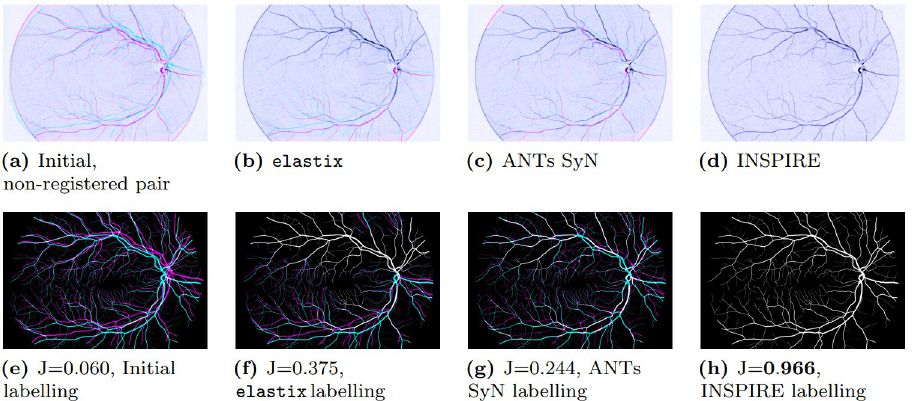
Fig 1. Example of registration of retinal images. Top row (as magenta/cyan overlays of the corresponding image pair; the better the alignment of the vessel networks, the less magenta/cyan colour visible in the image): (a) Initial deformation, and the results of registration using (b) elastix [11], (c) ANTs SyN [10], and (d) INSPIRE. Bottom row : The respective (Ground Truth) segmented vessel networks in the observed images in the top row (only used for evaluation, not for registration), with their corresponding Jaccard index (J). We observe that elastix (b, f) registered reasonably well the upper part of the vessel network, but performed poorly on the lower region. ANTs SyN (c, g) registered some parts of the image well, but failed to obtain an accurate overall alignment, and produced severe distortions and artefacts. INSPIRE produced a very accurate alignment, with barely visible errors. Performance on the whole Retinal dataset is summarized in Fig 4.